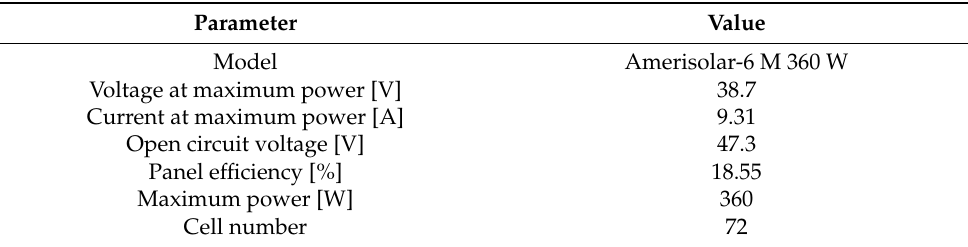
Table 3. Solar PV panel specifications